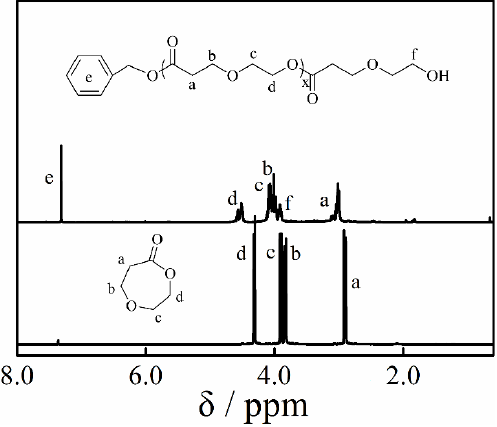
Figure 1 . 1 H NMR spectra for DXO and PDXO (Table 1, H1). Figure 1. 1 H NMR spectra for DXO and PDXO (Table 1,